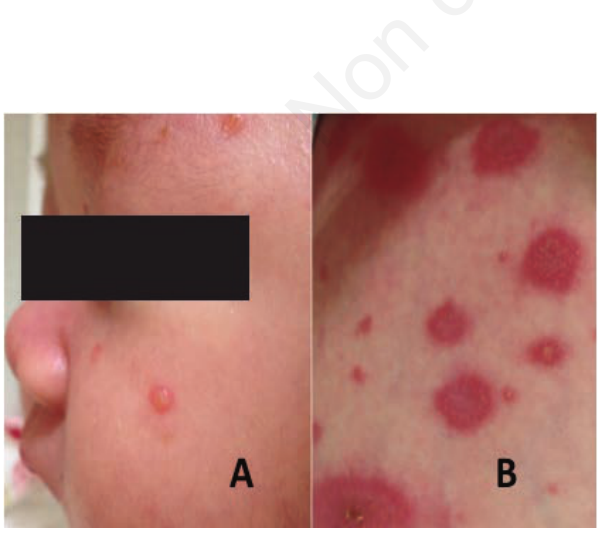
Figure 2. Biopsied specimen of skin shows a confluent neu- trophilic infiltrate in the dermis and